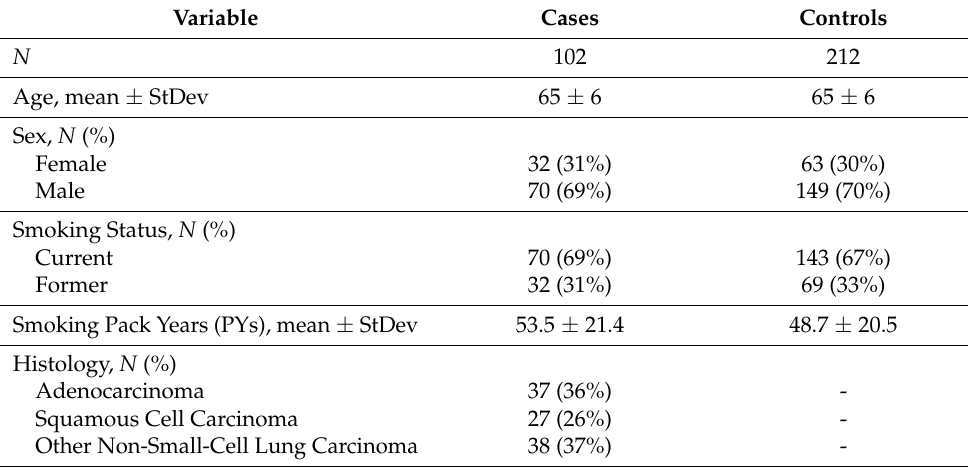
Table 1. Serum cohort patient and tumor characteristics. StDev, Standard